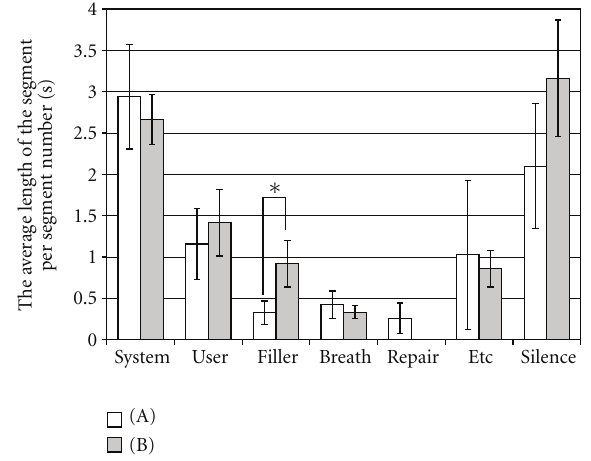
Figure 6: L 2 of each class ( ∗ P < 0 .